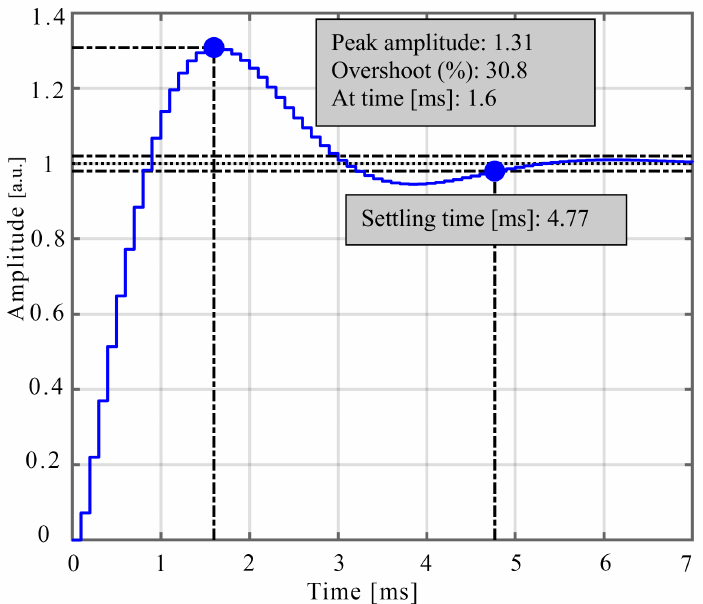
Figure 4. Voltage control step response estimated with